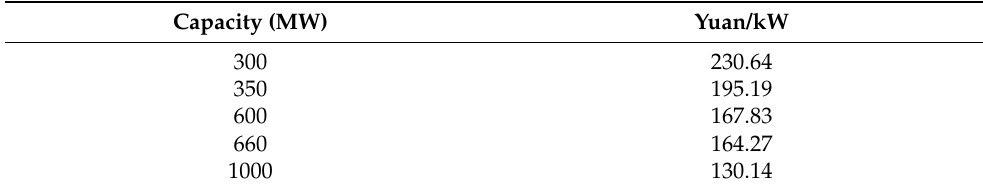
Table 2. Investment density of desulfurization